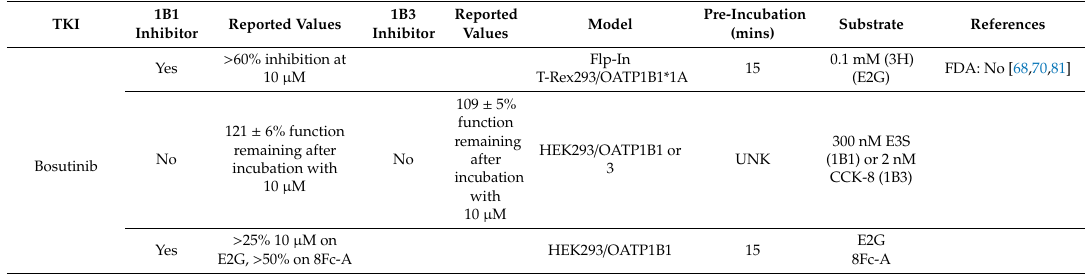
Table 2. Inconsistencies in reporting OATP1B inhibition by TKIs in published literature.